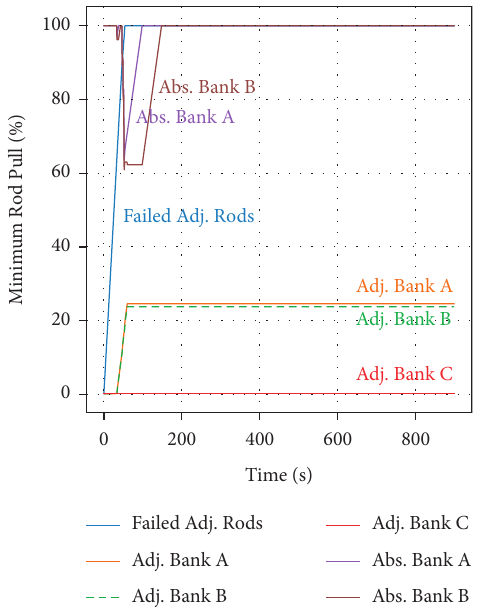
Figure 19: Adjuster and absorber levels for adjuster rod failure transient.